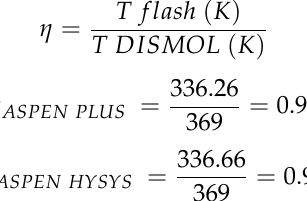
Table 1. Results of the DISMOL simulator, ASPEN PLUS and that developed in ASPEN HYSYS. Parameters